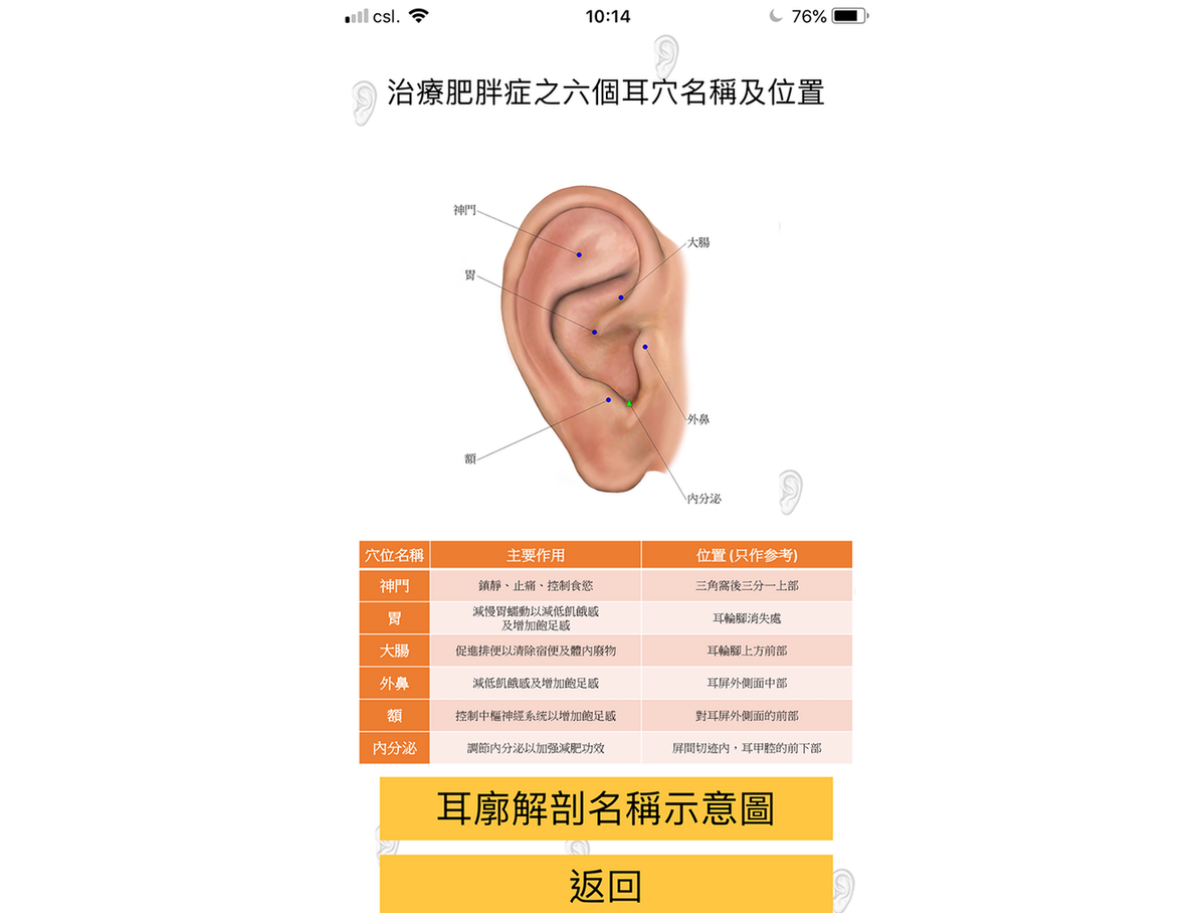
Figure 3. An ear diagram indicating the locations and functions of the 6 ear points in the